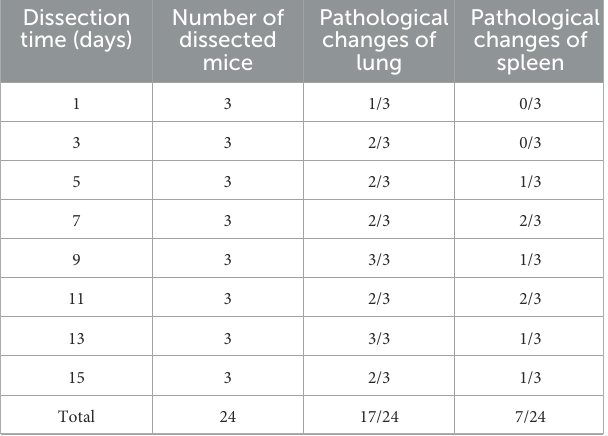
TABLE 1 Gross pathological changes in the infected mice.